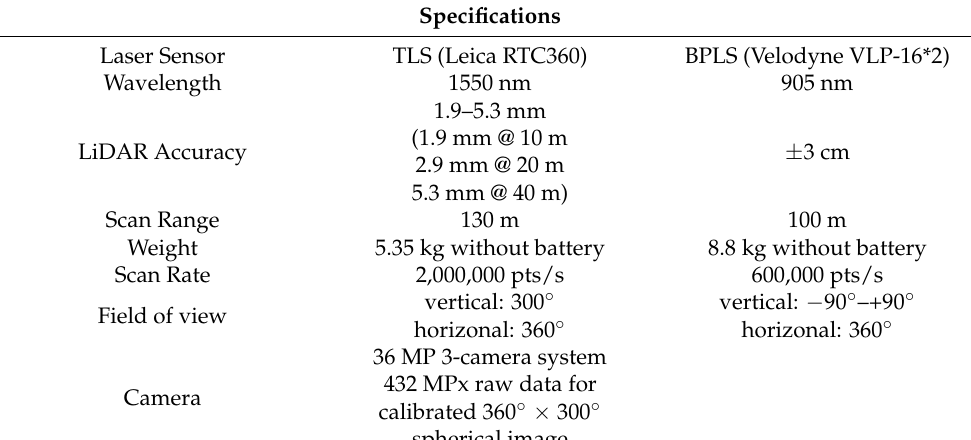
Table 2. Description of the TLS (RTC360) and the BPLS (LiBackpack D50).